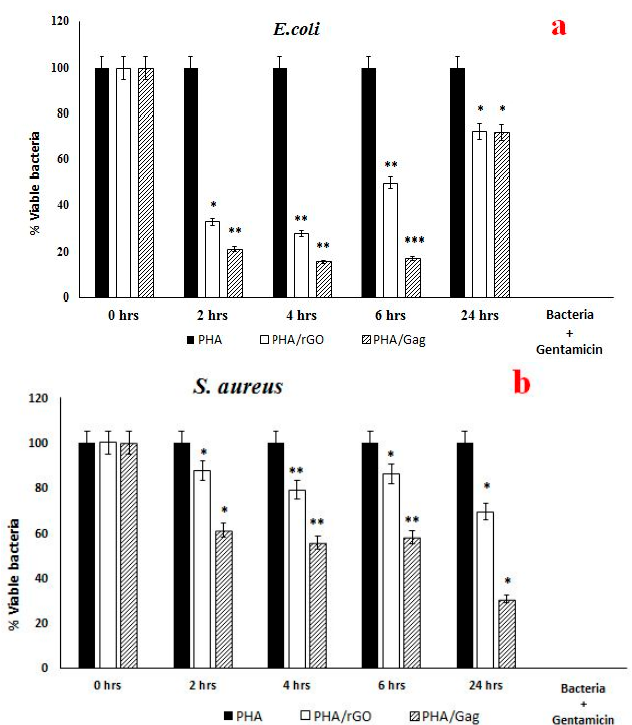
Figure 10. Bactericidal activity of PHA, PHA/rGO, and PHA/GAg against test organisms. PHA/rGO and PHA/GAg showed significant ( p value <0.05) bactericidal effects towards Escherichia coli ( a ), and Staphylococcus aureus ( b ). p values were determined using a two-sample t -test distribution, (*) is <0.05; (**) is <0.01; and (***) is <0.001. The result presented was the average of three different batches of as-spun scaffolds of each nanocomposites (PHA, PHA/rGO and PHA/GAg. Table 1. Representation of PHA, PHA/rGO, and PHA/GAg scaffolds’ antibacterial activity against E. coli and S. aureus. Test Samples Antibacterial Activity against E. coli Antibacterial Activity against S. aureus